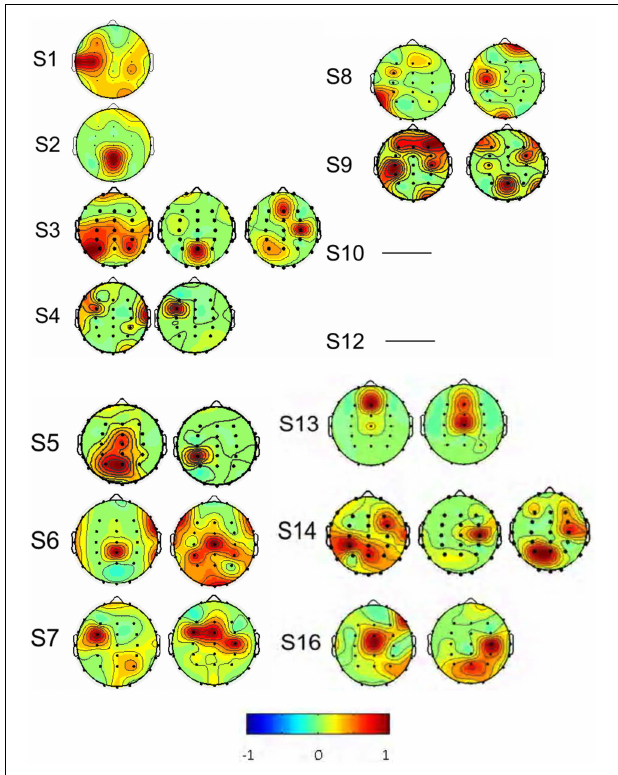
FIGURE 7 | The spatial distributions of the interested source signals from Fourier-ICA analysis. Results were from 14 of the 16 subjects, and subjects S 11 and S 15 were excluded. No source components were found in the subjects S10 and S12. Signal space distribution was denoted by selected color circles and color intensity (–1 to 1) on the map. Blue represents –1, Red represents 1.